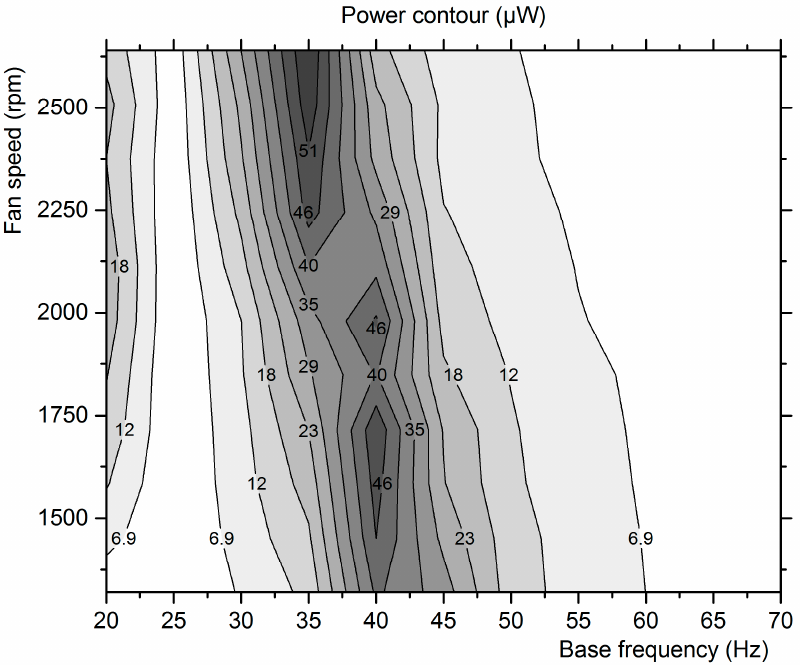
Figure 10. Contour map of mean power output after 150 s for fan and base frequency combinations.